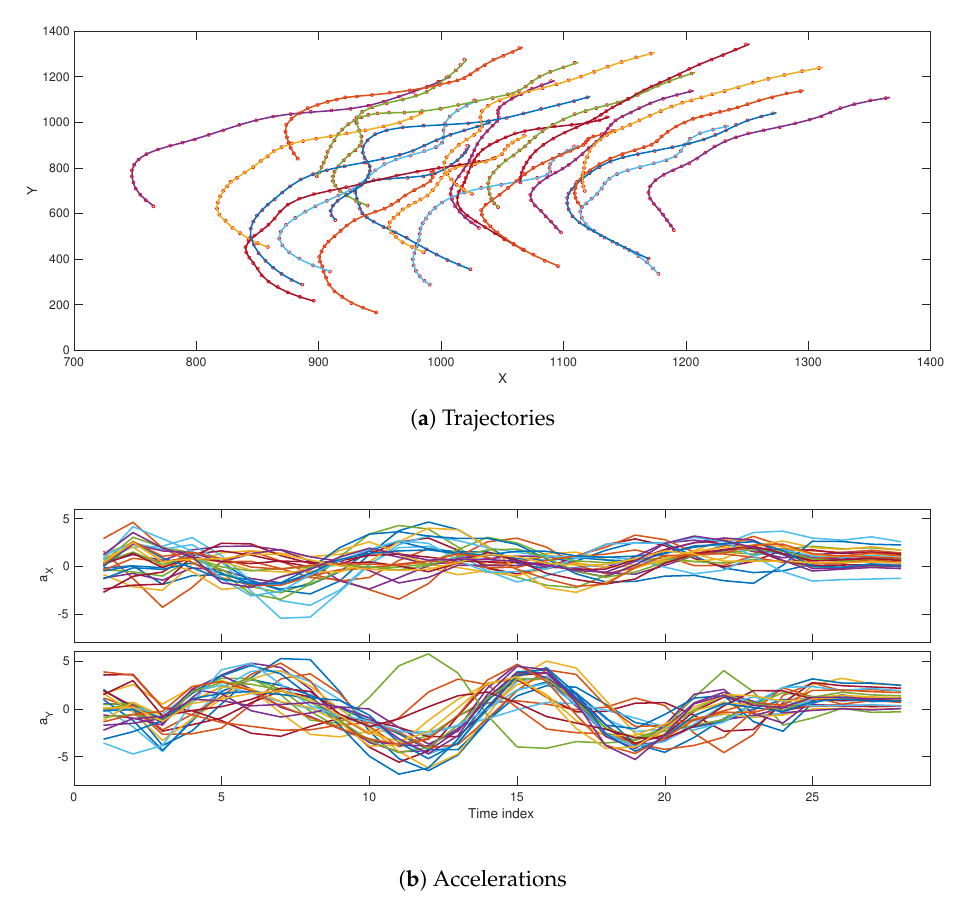
Figure 12. Shadowing filter applied to positional data from a group of ducks moving on the water surface. The shadowing filter successfully tracked the 25 individuals. In ( a ), we tracked the trajectories of the 25 ducks (the coloured solid lines) from the positional observations (red circles). In ( b ), we used the tracking algorithm to estimate the corresponding acceleration profiles for each duck (colours refer to different